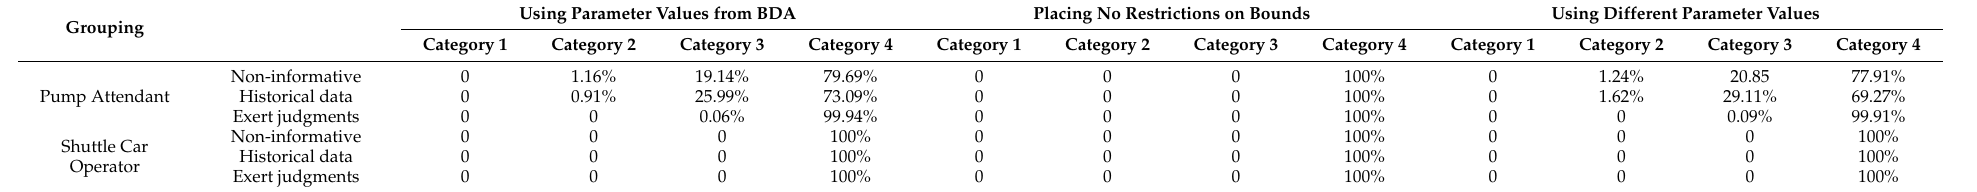
Table 4. Sensitivity analysis to compare the parameter values used for the lower and upper bound in this